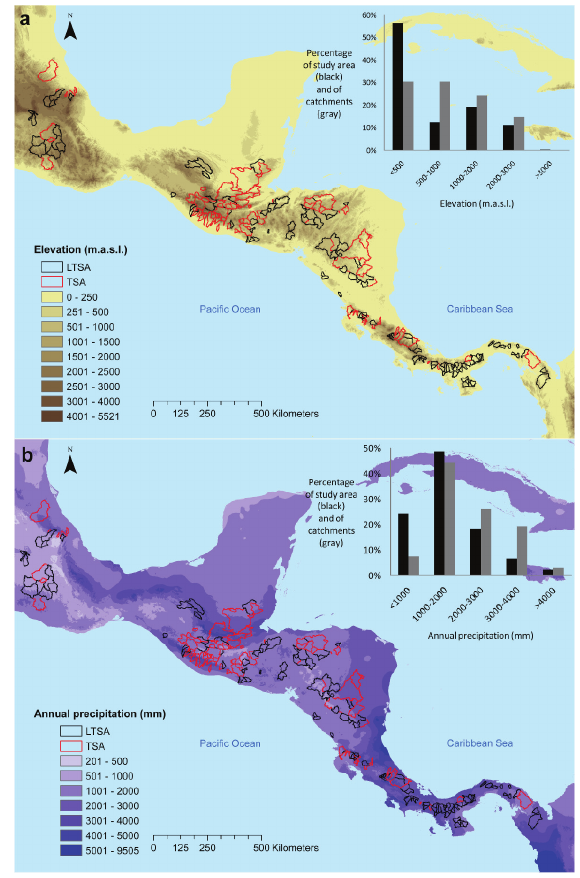
Fig. 1. Maps of the digital elevation model (a) and annual precip- itation (b) in the Mesoamerican region and in Long Time Series Average (LTSA) and Time Series Average (TSA)